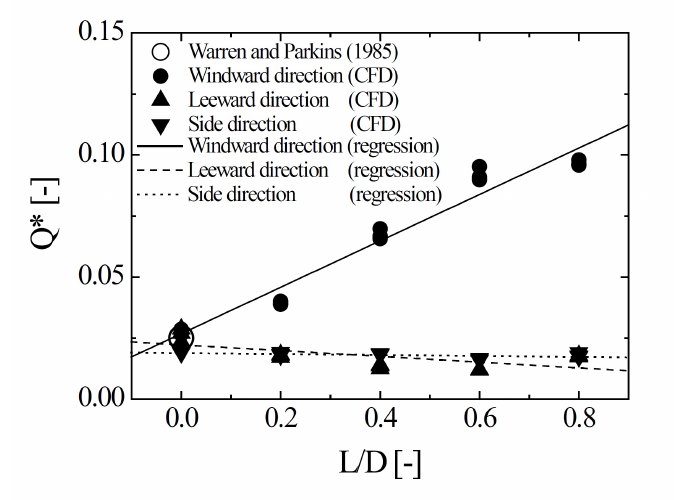
Figure 7. Effectiveness of the overhang based on a dimensionless ventilation